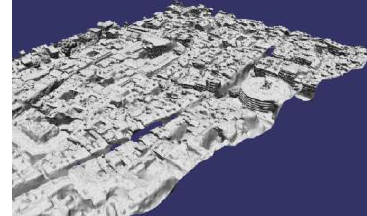
Fig 8. Optimized 3D TIN network